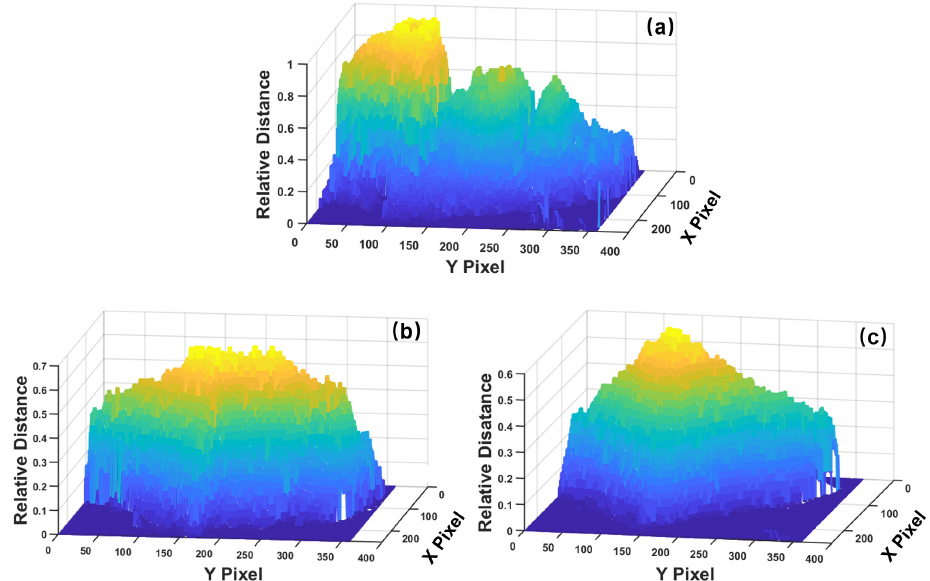
Figure 8. 3D view of the bottom face acquired from the ToF camera: ( a ) without a mask, ( b ) with a surgical mask, and ( c ) with an N95 mask.